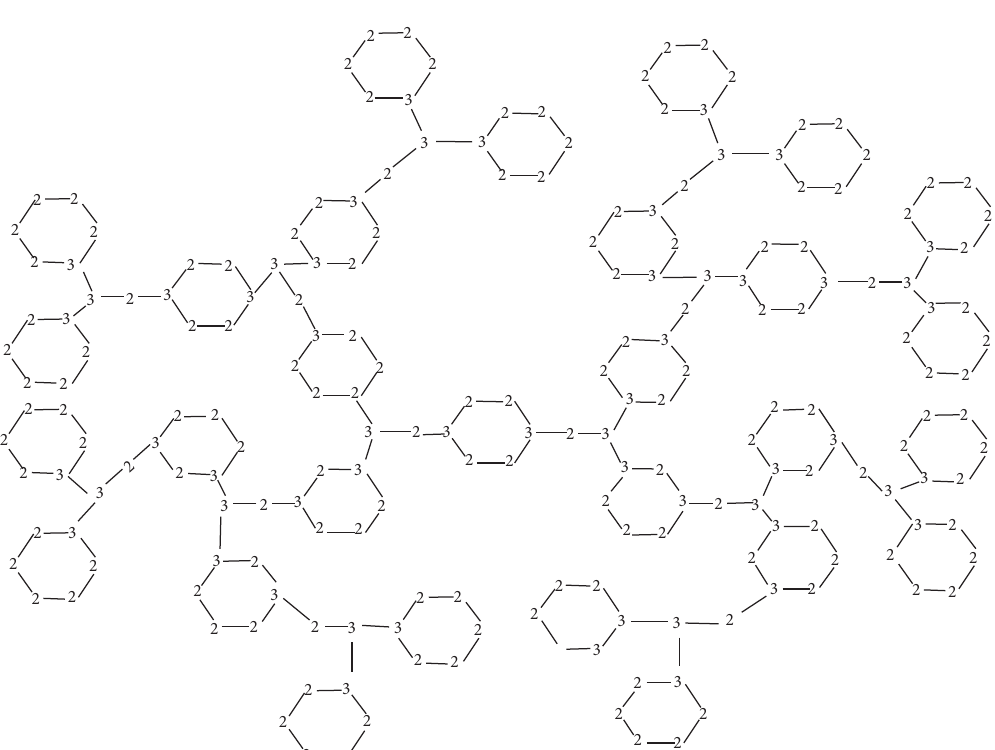
Figure 5: D [ 2 ] along with the degree of each vertex. 1